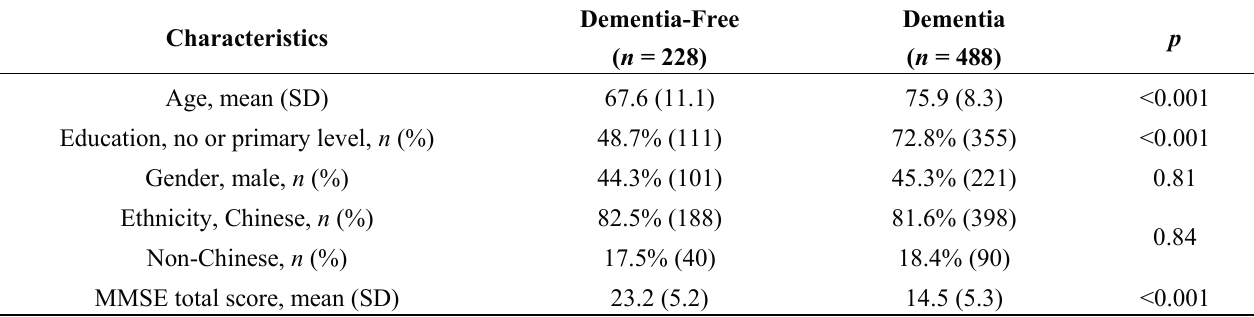
Table 1. Demographics and Mini-Mental State Examination (MMSE) total scores in dementia and dementia-free groups.